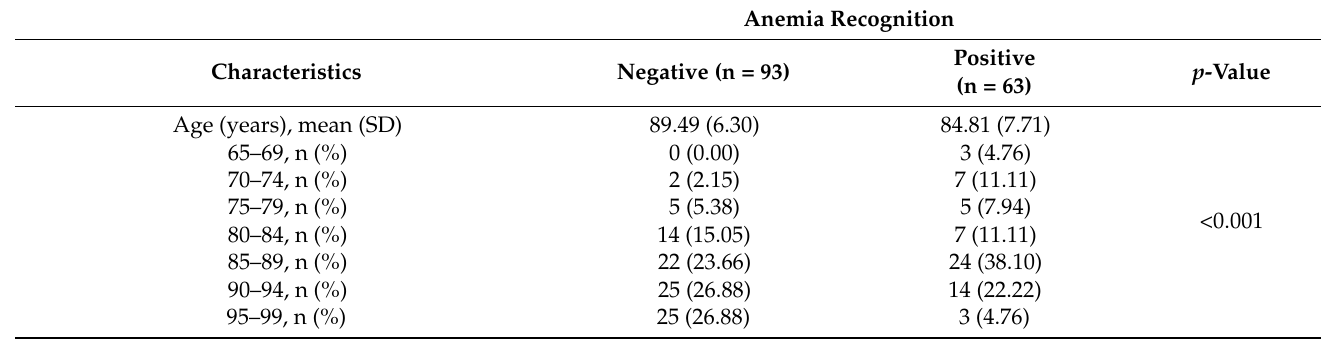
Table 1. Characteristics of the study participants (n =